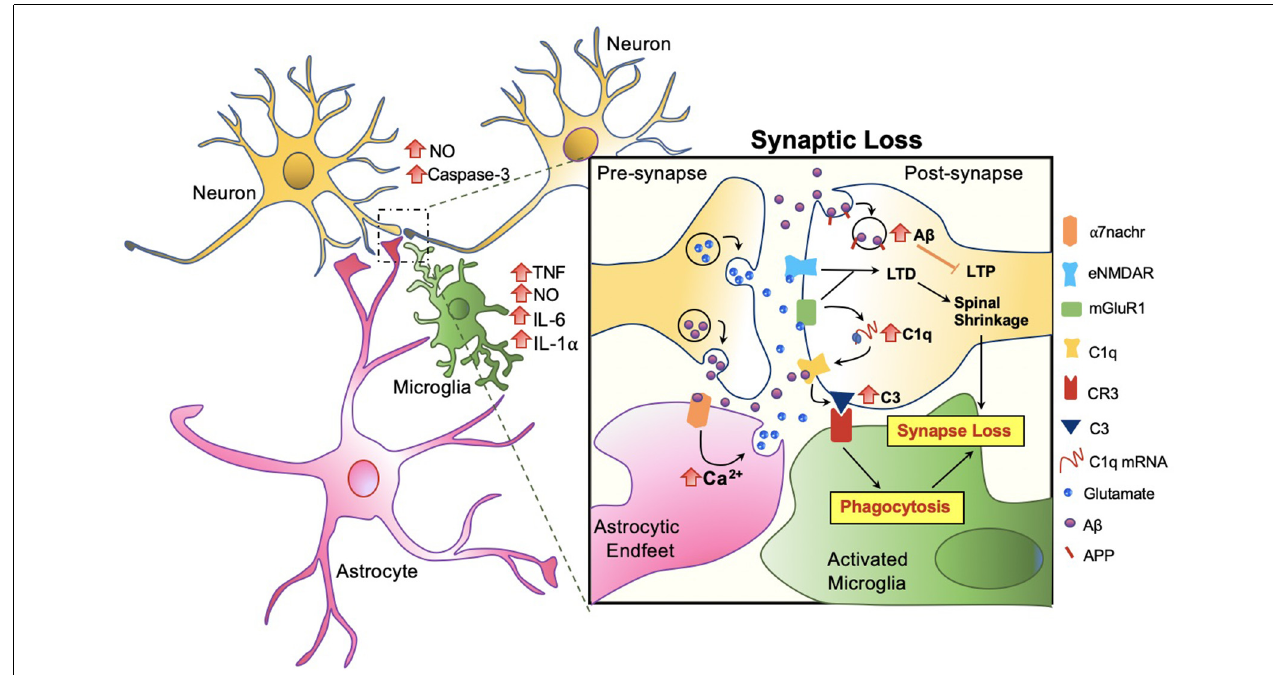
FIGURE 5 | Microglia mediated synaptic loss in AD. Synaptic engulfment by activated microglia can occur through the direct effects of A β on synapses or indirect action via astrocytes. Soluble factors, tumor necrosis factor (TNF), nitric oxide (NO), interleukin-6 (IL-6), interleukin 1 alpha (IL-1 α ) are released by microglia, and NO and Caspase-3 by neurons, contributing towards the overall toxicity at the synapse (Rajendran and Paolicelli, 2018). In synchrony, these mechanisms result in spinal shrinkage, activated microglia, and ultimately the loss of the